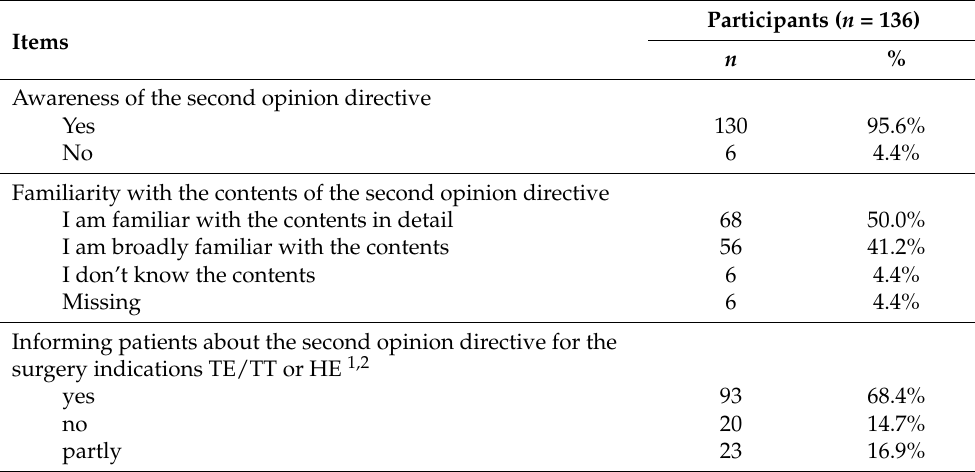
Table 2. Results of the ZWEIT Physician Questionnaire Survey Study among Otolaryngology and Gynaecology Practitioners in Germany